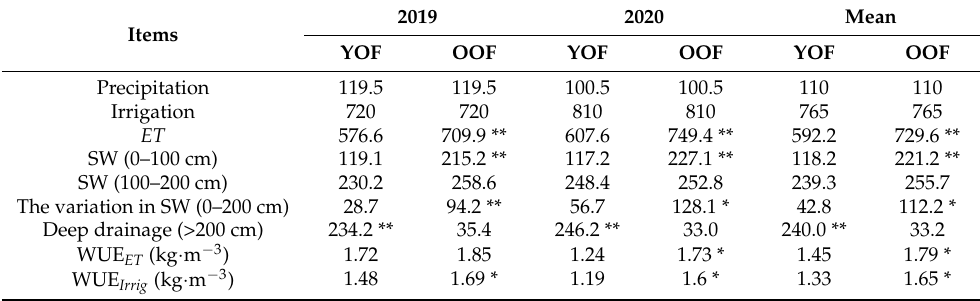
Table 3. Apparent water balance (mm) of soil–plant system in the YOF and